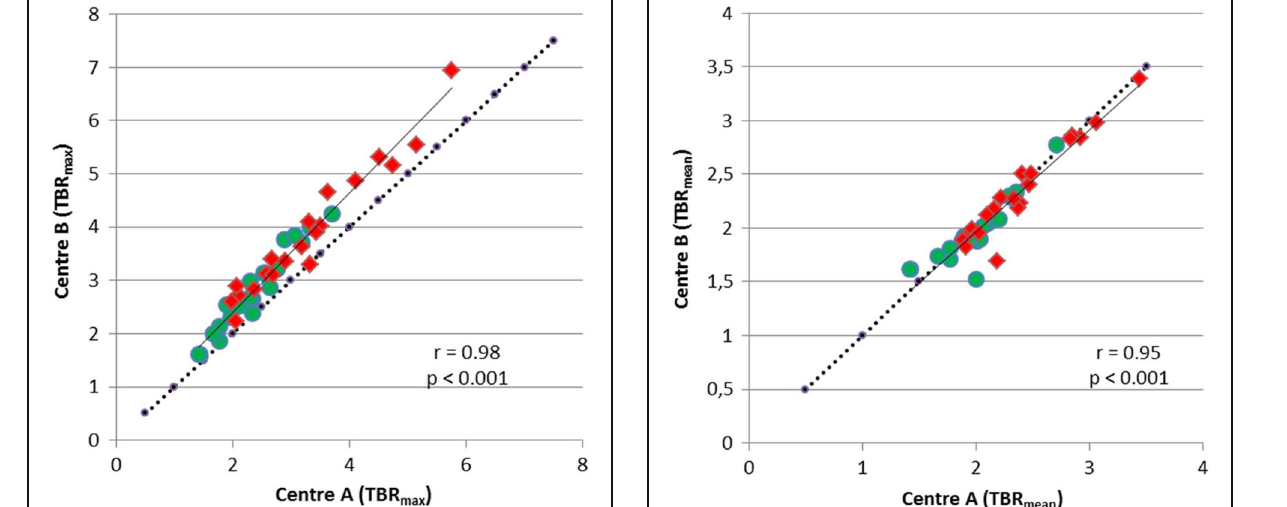
B 0.73 ± 0.69 SUV/h). For both TTP and slope, ROC